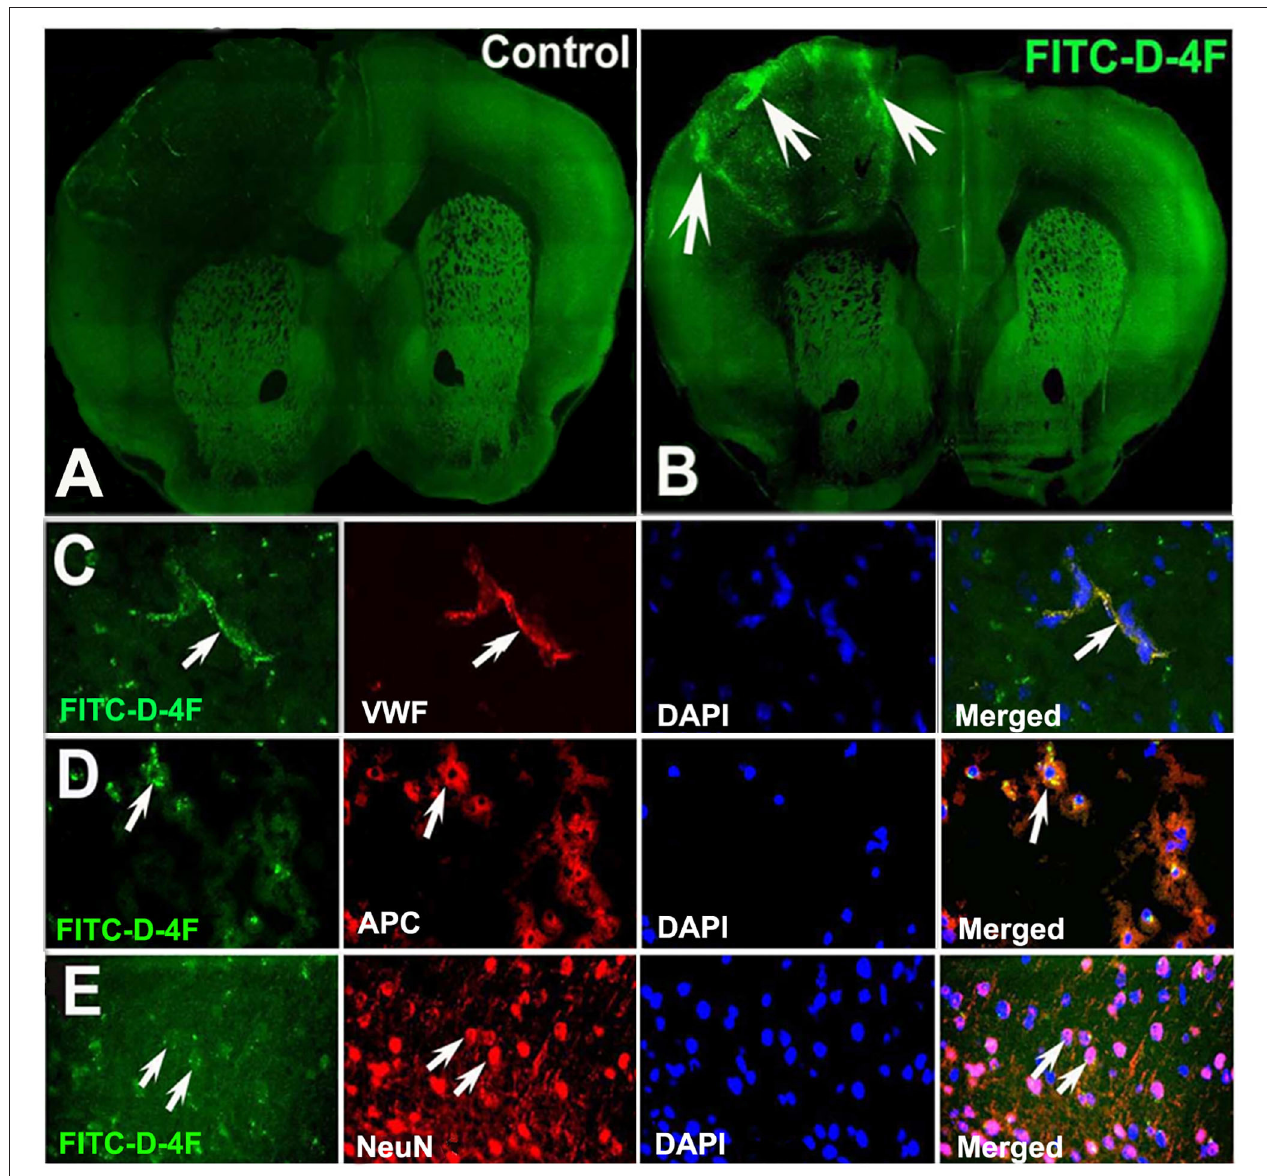
FIGURE 7 | D-4F can pass through the BBB and enter into the ischemic brain, and was co-localized with vWF + -vessels, APC + -OLs, and NeuN + -neurons in the IBZ of the ischemic brain of T2DM-stroke mice. The confocal image of mouse brain in control (A) and FITC-D-4F (B) . D-4F was co-localized with vascular vessels (C) , OLs (D) and neurons (E) ,